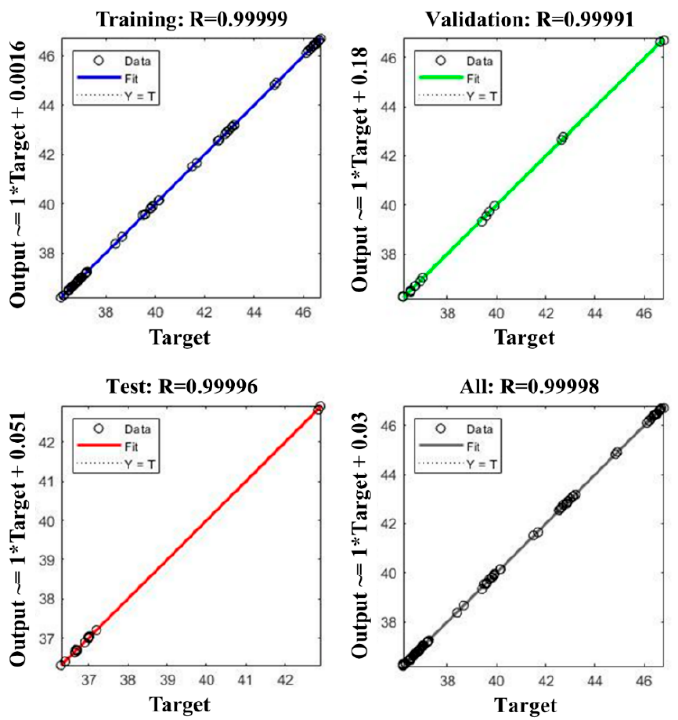
Figure 6. Regression results of ANN model.